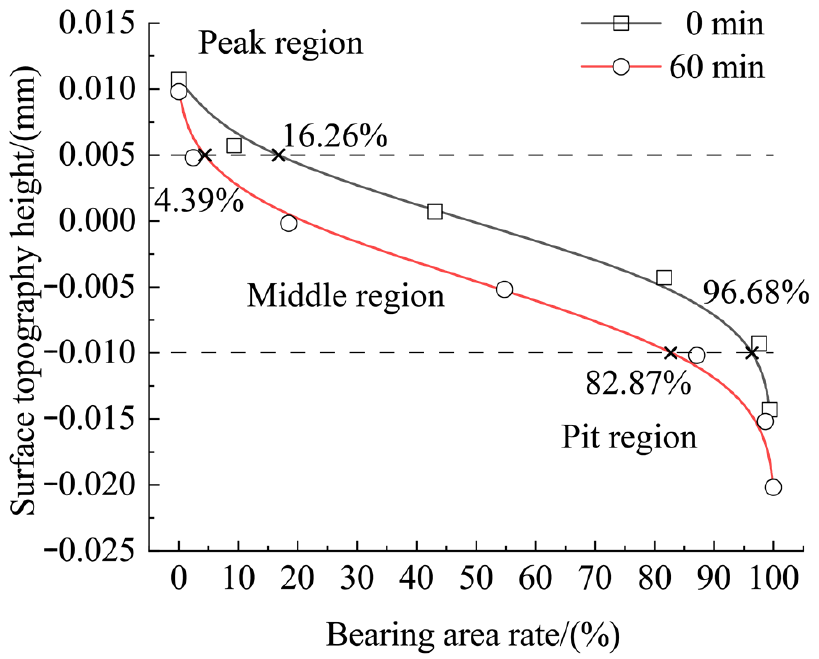
Figure 10. Bearing area curves of surface topography.